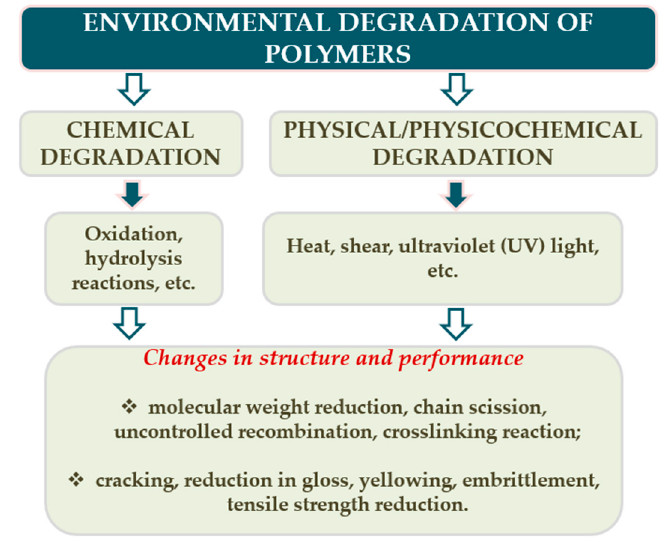
Figure 1. Changes in polymers caused by the chemical (oxidation, hydrolysis) and physicochemical (heat, shear, UV light) degradation factors.